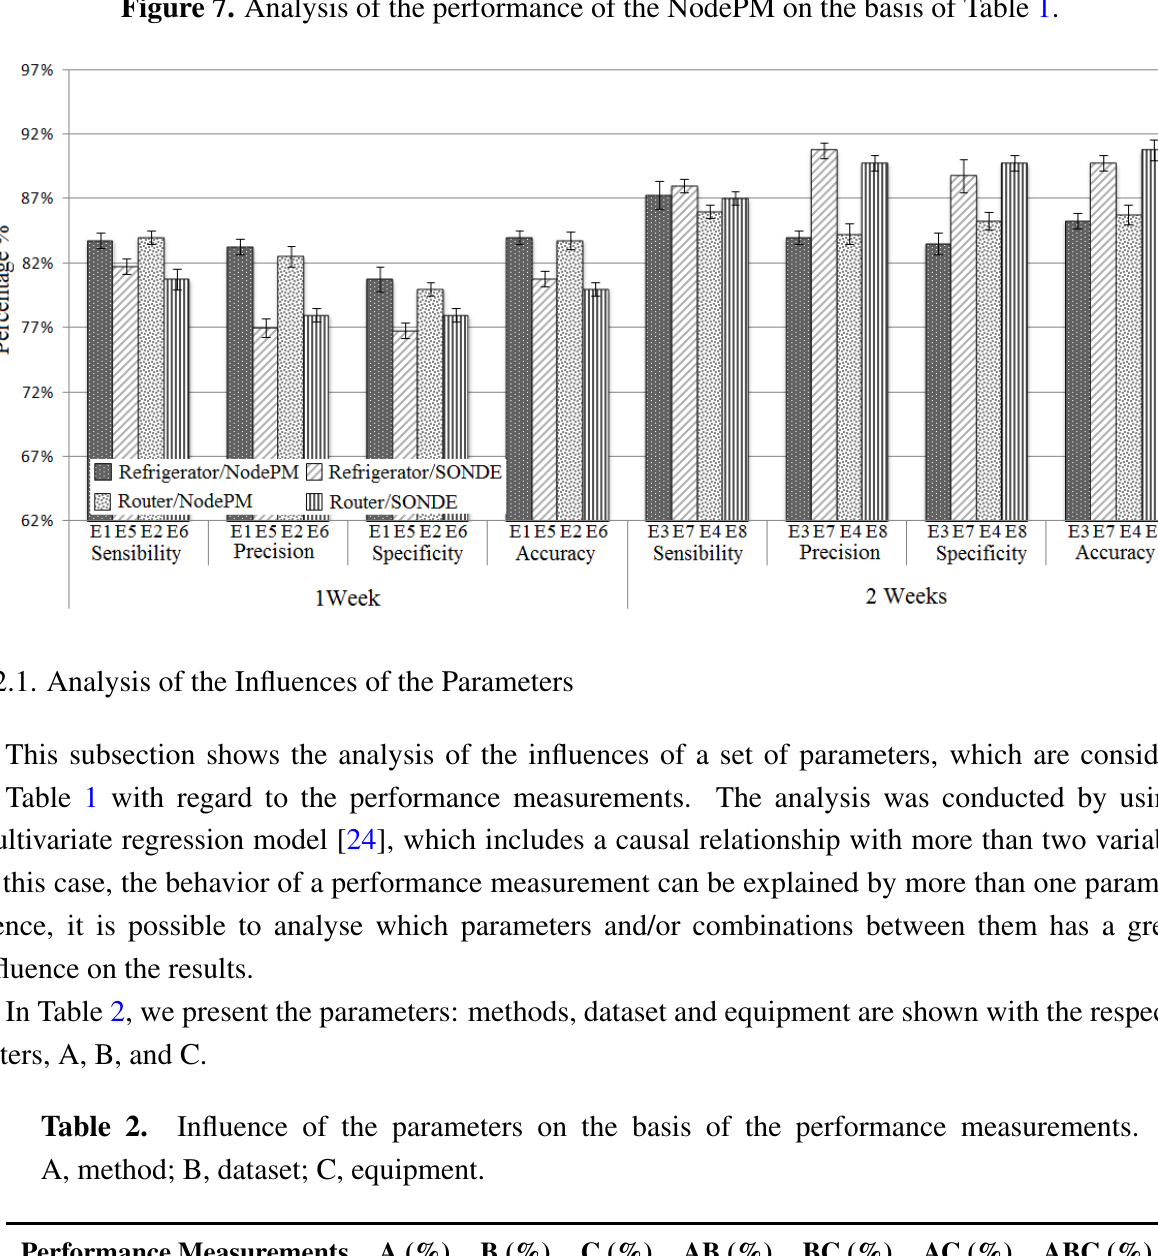
Figure 7. Analysis of the performance of the NodePM on the basis of Table